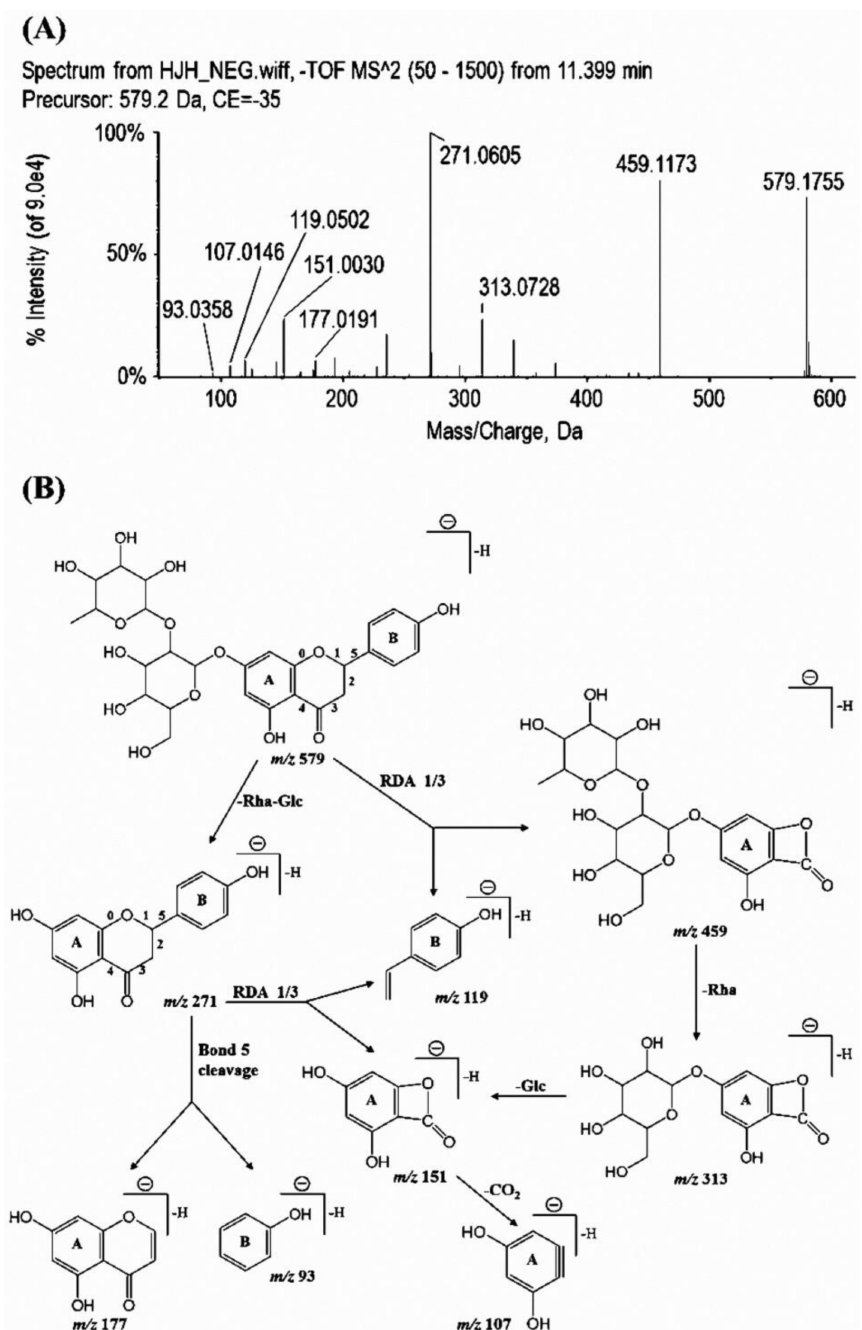
Figure 1. Product ion spectra ( A ) and proposed fragmentation pattern ( B ) of deprotonated